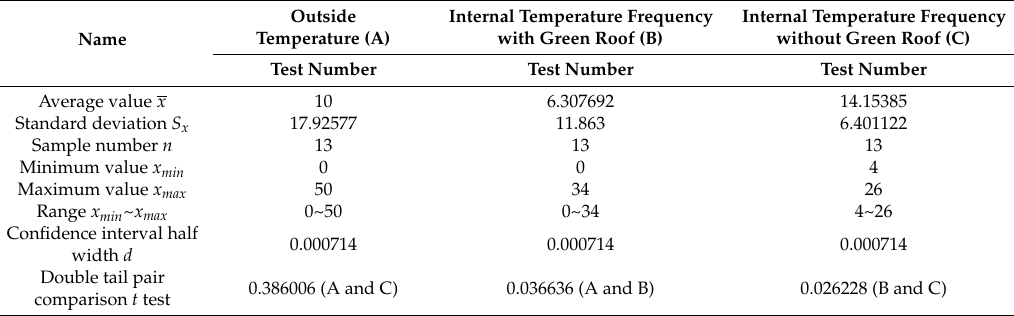
Table 2. Statistical tests of inside surface temperature.